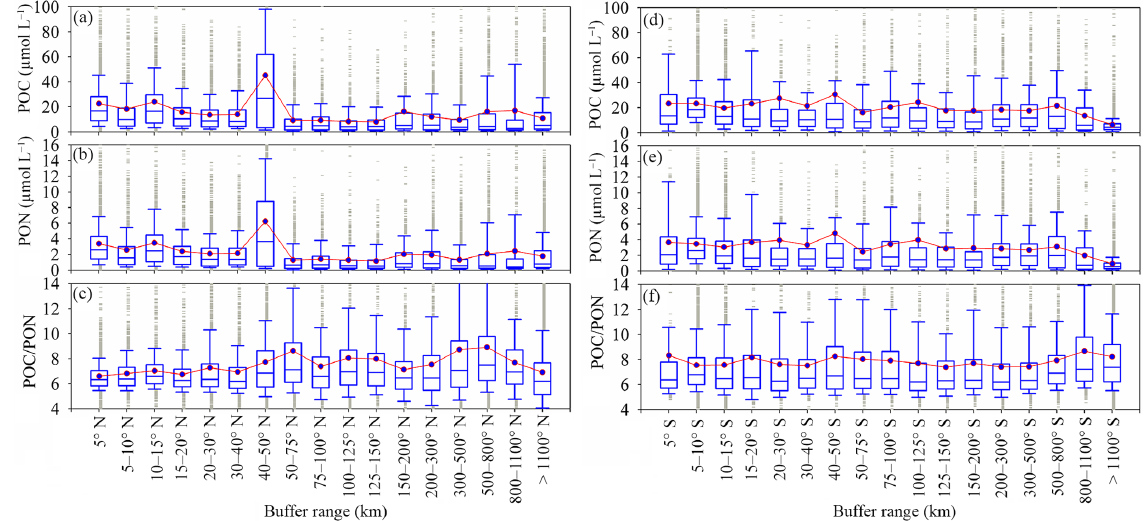
Figure 5. Variation of POC, PON and POC / PON with distance from shore. The number of samples for each buffer is listed in Table S4. The box plots show the median and 25th and 75th percentiles. The red line with green boxes shows the mean value for each range.